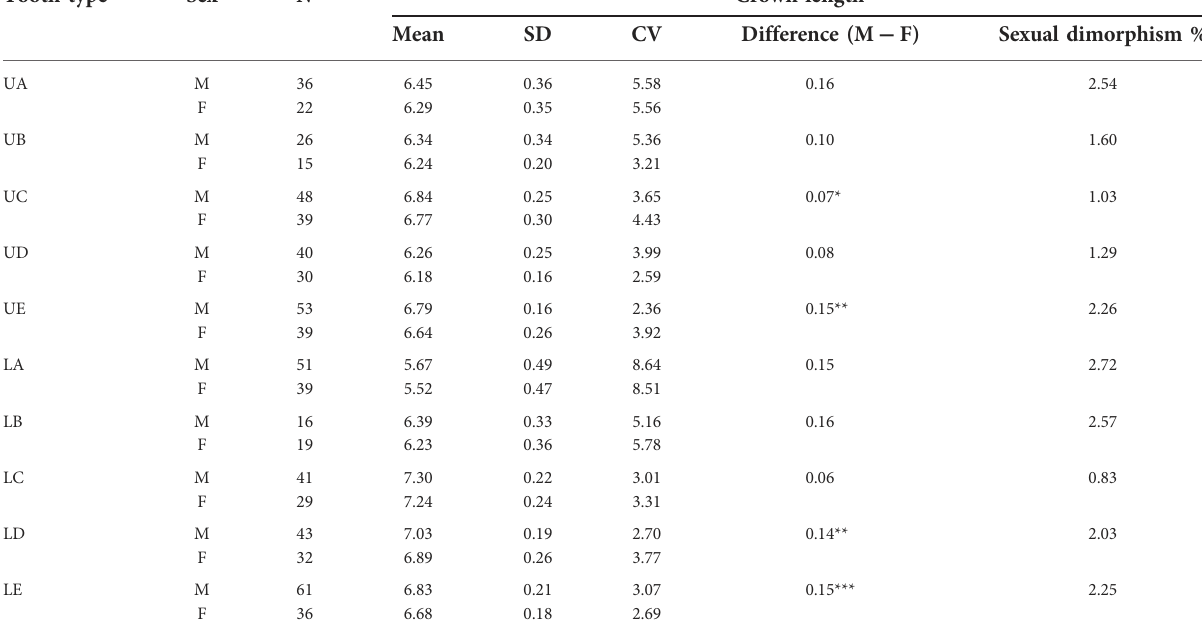
TABLE 6 Crown length (mm) and sexual dimorphism of the total sample. Tooth type